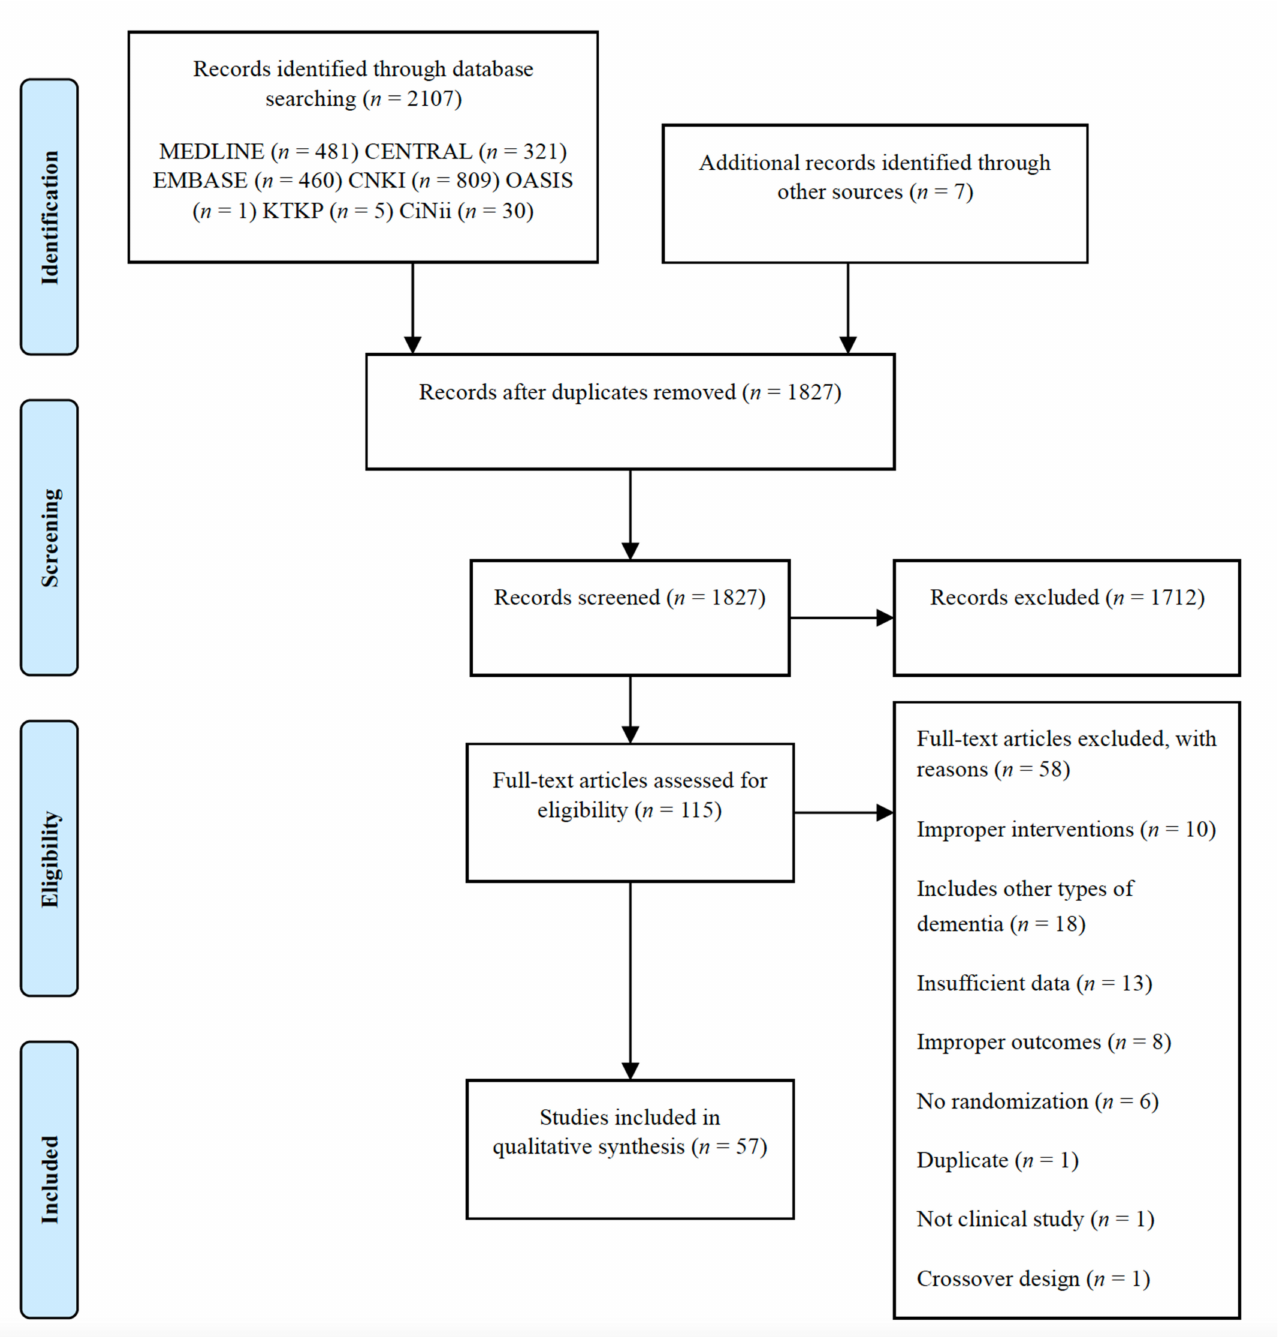
Figure 1. The PRISMA flow chart of study